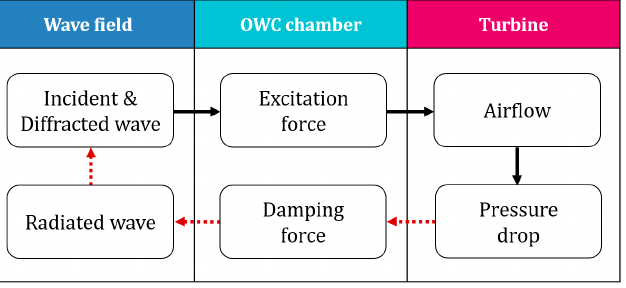
Figure 2. Flow diagram of wave–chamber–turbine interaction mechanism of an OWC-WEC.